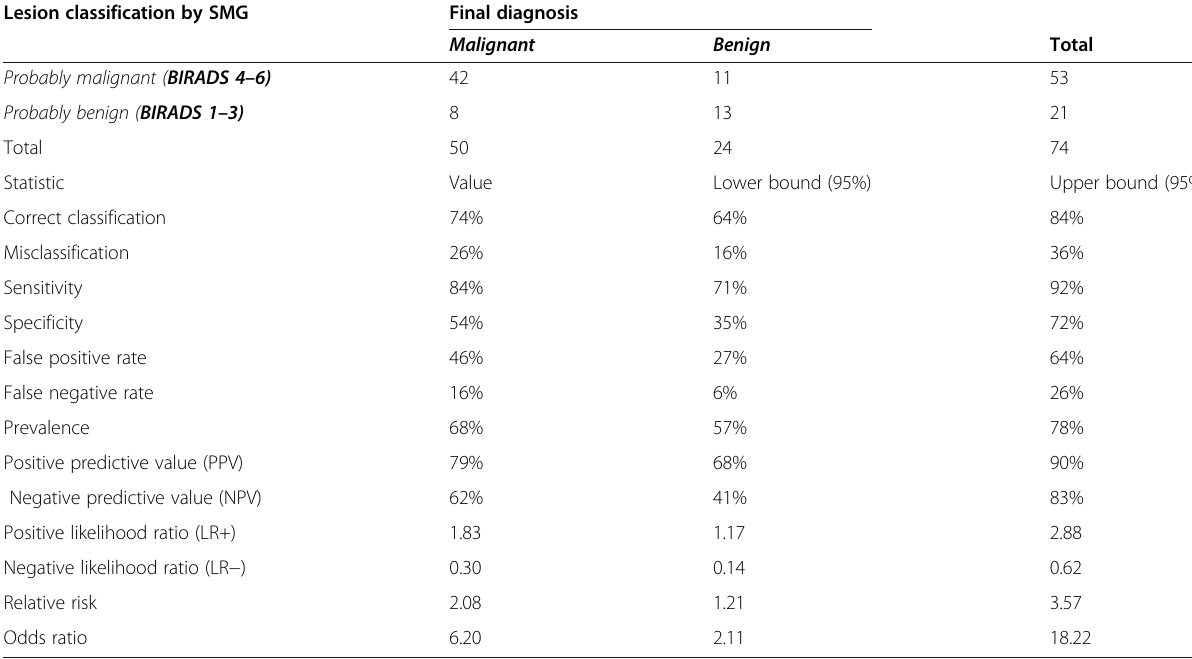
Table 6 Diagnostic accuracy of SMG in tested patients with ACR grade C/D versus the result of biopsy or follow-up as the gold standard for lesion classification